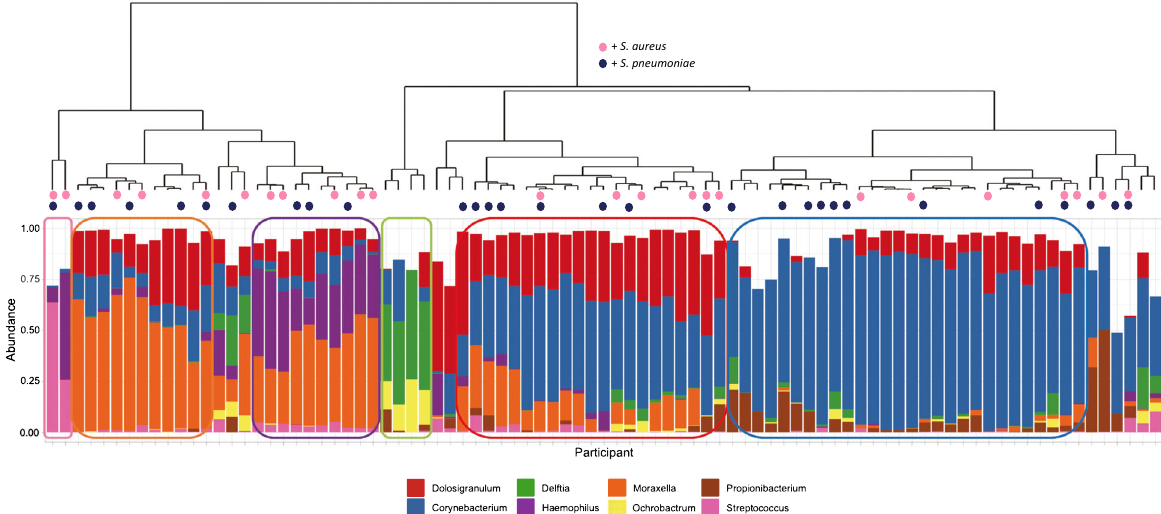
Fig. 5 Hierarchical clustering of nasal samples with Bray – Curtis dissimilarity using genus-level relative abundances. The dendrogram (top) shows clustering of samples with the below bar chart showing the relative abundance of the eight most commonly observed Genera. Six clear clusters were observed including a Corynebacterium dominant pro fi le ( n = 28; 35.4%), a Corynebacterium / Dolosigranulum pro fi le ( n = 16; 20.3%), a Moraxella pro fi le ( n = 10; 12.7%) a Moraxella / Haemophilus pro fi le ( n = 10; 12.7%), a Delftia / Orchobactum pro fi le ( n = 4; 5.1%) and a fi nal group of two samples characterised by high Streptococcus , in one case with Haemophilus . Culture results for S. aureus (dark blue) and S. pneumoniae (pink) are shown as coloured circles at the tips of the dendrogram. There is no clear distribution of individuals who were culture positive for either